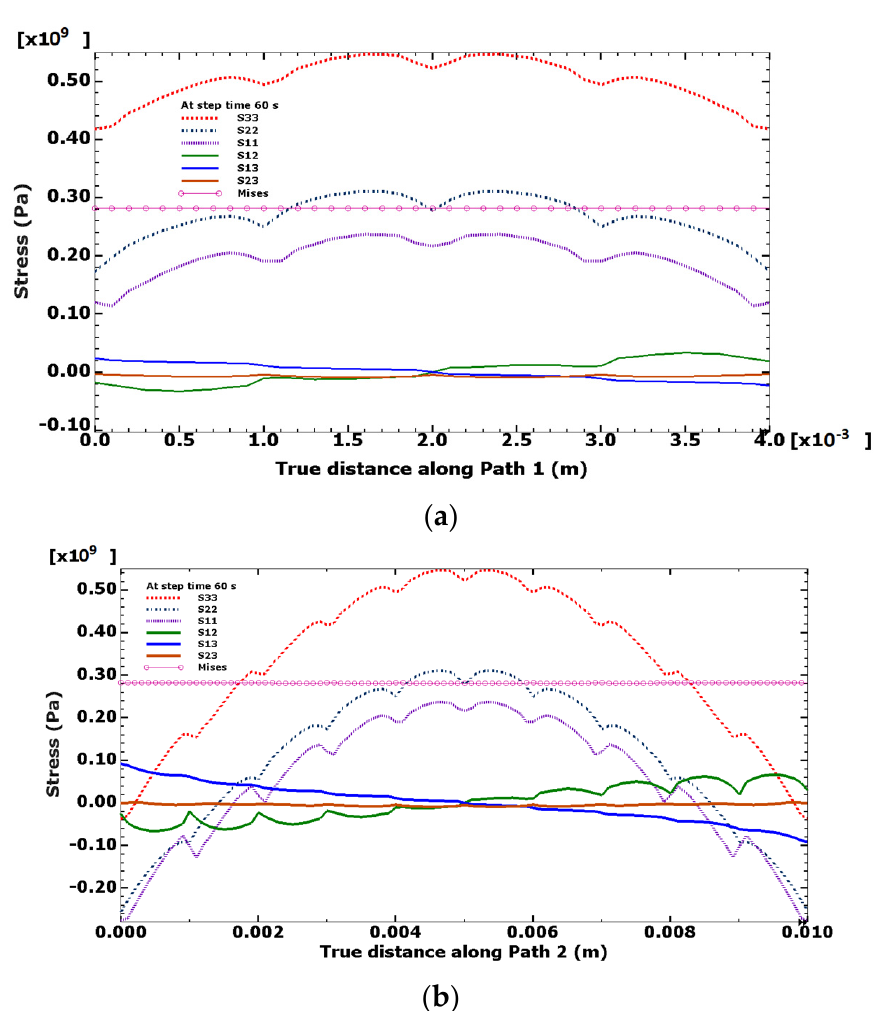
Figure 8. Meso-level residual stresses at cooling time 60 s ( a ) along Path 1 and ( b ) Path 2. The present contribution is in line with the multiscale framework that covers the thermal and mechanical failure analysis of extended microstructural regions. The submodeling technique (a flexible strategy used to calculate plastic strains, temperature gradients, and residual stresses to any number of levels) was used to mesh a local portion of the part with a refined mesh, based on the interpolation of the solution from the initial coarse macro global model. In a future work, the presented meso-level residual stresses will be validated by a comparison to the experimental results performed under the same welding and boundary conditions. In addition, more numerical and experimental work will be performed to compare the best welding parameter combination to minimize residual stresses and the formation of stray and equiaxed grains. Depending on the experimental technique and magnification used, it is observed that dendrite secondary arm spacing belongs to the micro scale, cooling rate belongs to the macro scale, and residual stresses belong to the macro, meso or micro scale. Therefore, to find new expressions that link, for example, the grain substructure with the cooling rate that is imposed on the welding during solidification, the experimental and numerical work should be conducted at the same scale. At the present time, the connection between the scales is yet unclear [26]. An interesting overview of the state of the art in laser welding simulation can be found in refs. [27–29]. Figure 9a describes Path 3 (see also Figure 7a), which is used to calculate the stresses vs. true distance along Path 3 shown in Figure 9b. The stress evolution at location D1 during the first 10 s of the welding process is shown in Figure 9c. The point D1 located